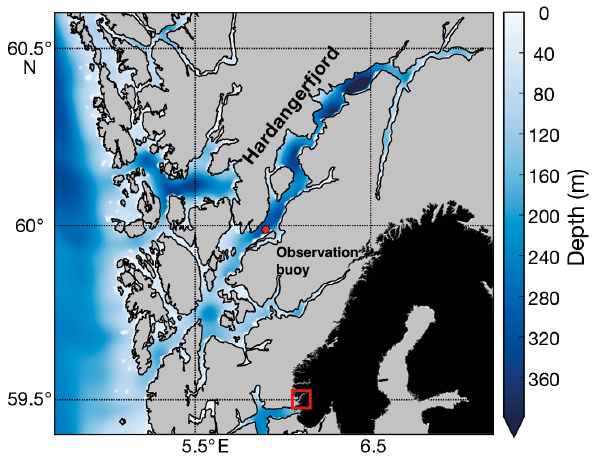
Fig. 1. Study area in the Hardangerfjord, Norway. The posi- tion of the observational buoy where we collected current data for model validation is indicated ( d ). Inset: Scandinavian Peninsula (study area marked with h